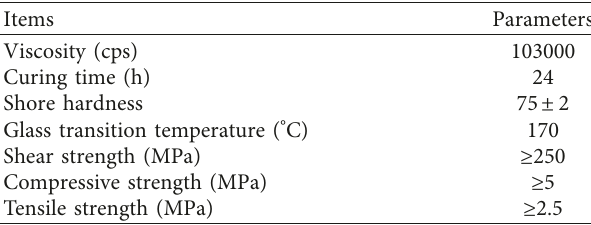
Table 2: Recycled aggregate concrete composition. Table 3: Performance specifications of the epoxy adhesive.